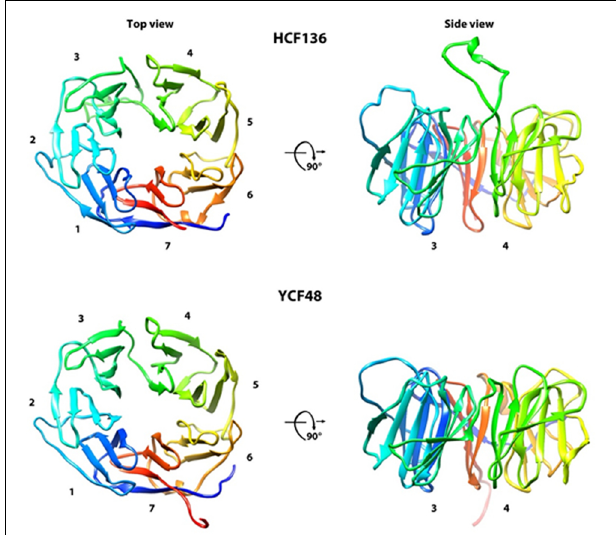
FIGURE 2 | Predicted structure of the mature HCF136 in chloroplasts and YCF48 in cyanobacteria. The structure of HCF136 in Arabidopsis (C-score 0.81 ± 0.09) and Thermosynechococcus elongatus strain BP-1 (C-score 0.92 ± 0.06) was calculated by I-Tasser (Yang et al., 2015) and is shown from the top and the side view demonstrating the position of the additional loop in the chloroplast